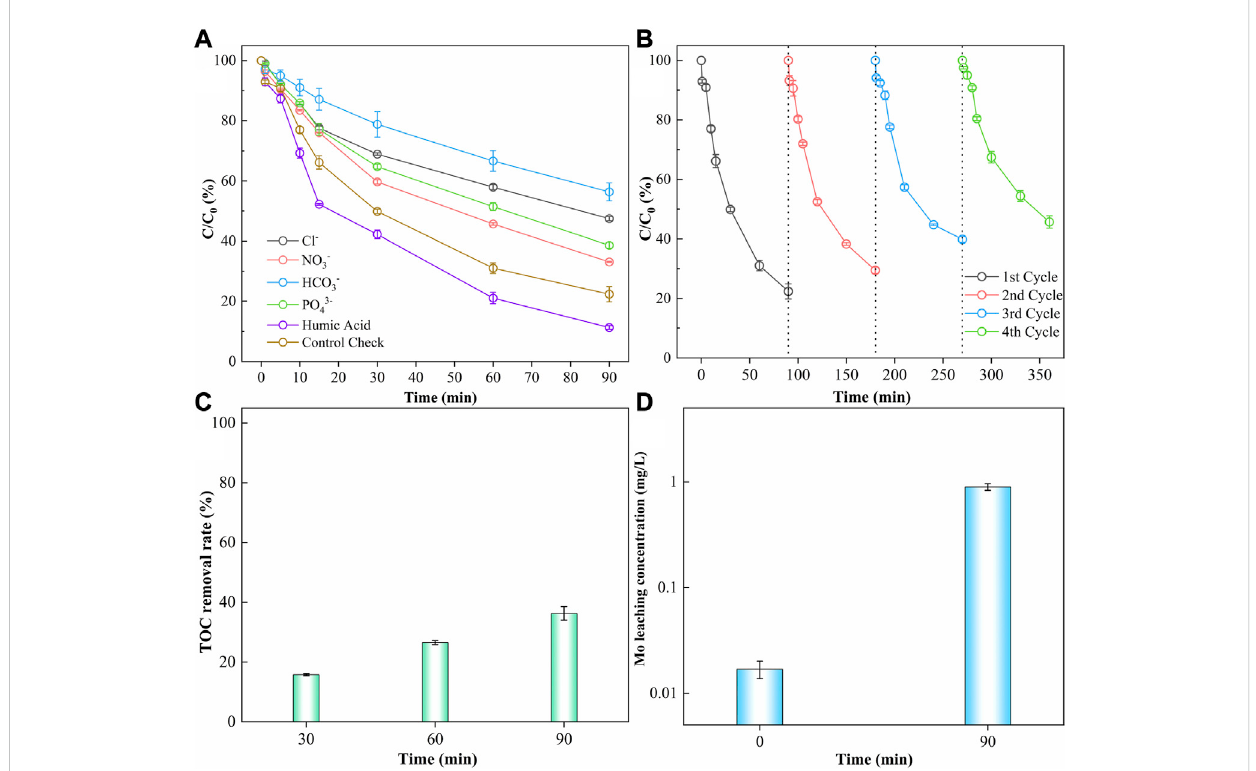
FIGURE 6 (A) In fl uenceofdifferentInorganicanionsandorganicmatters(HA)inthedegradationprocess(DMP=10 ppm,PMS=10 mmol/L,CMB@1T-MoS 2 = 0.5 g/L), (B) in fl uence of recycling of CMB@1T-MoS 2 (DMP = 10 ppm, PMS = 10 mmol/L, CMB@1T-MoS 2 = 0.5 g/L), (C) TOC removal rate of the degradation process (DMP = 10 ppm, PMS = 10 mmol/L, CMB@1T-MoS 2 = 0.5 g/L), (D) Mo leaching concentration of the degradation process (DMP